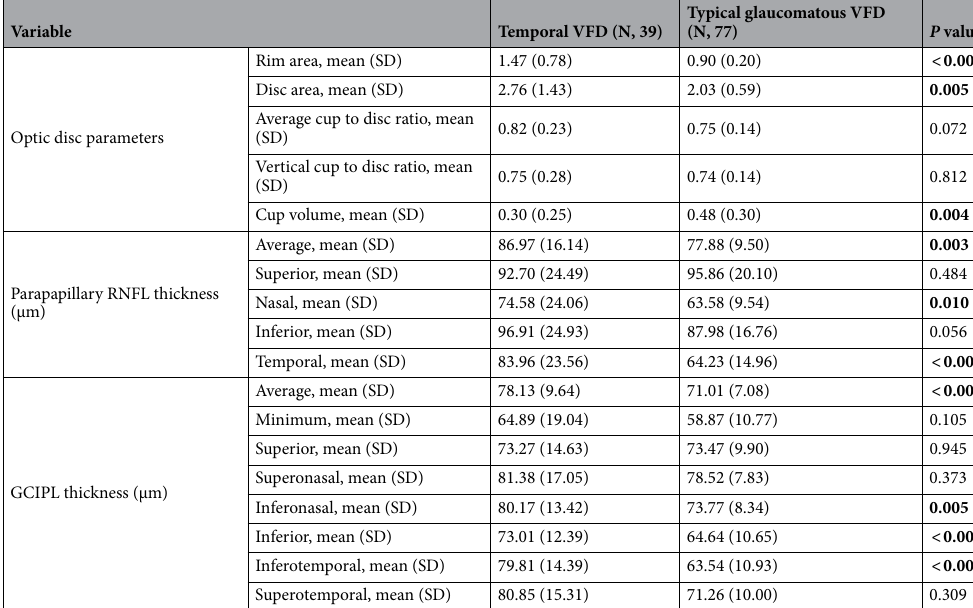
Table 4. Comparison of optical coherence tomography parameters. Values obtained from optical coherence tomography was corrected with the Littmann’s formula. VFD visual field defect, RNFL retinal nerve fiber layer, GCIPL ganglion cell inner plexiform layer. Mean values are presented with standard deviations. Student’s t-test after Propensity score match. Bold font indicates significant P values ( P <